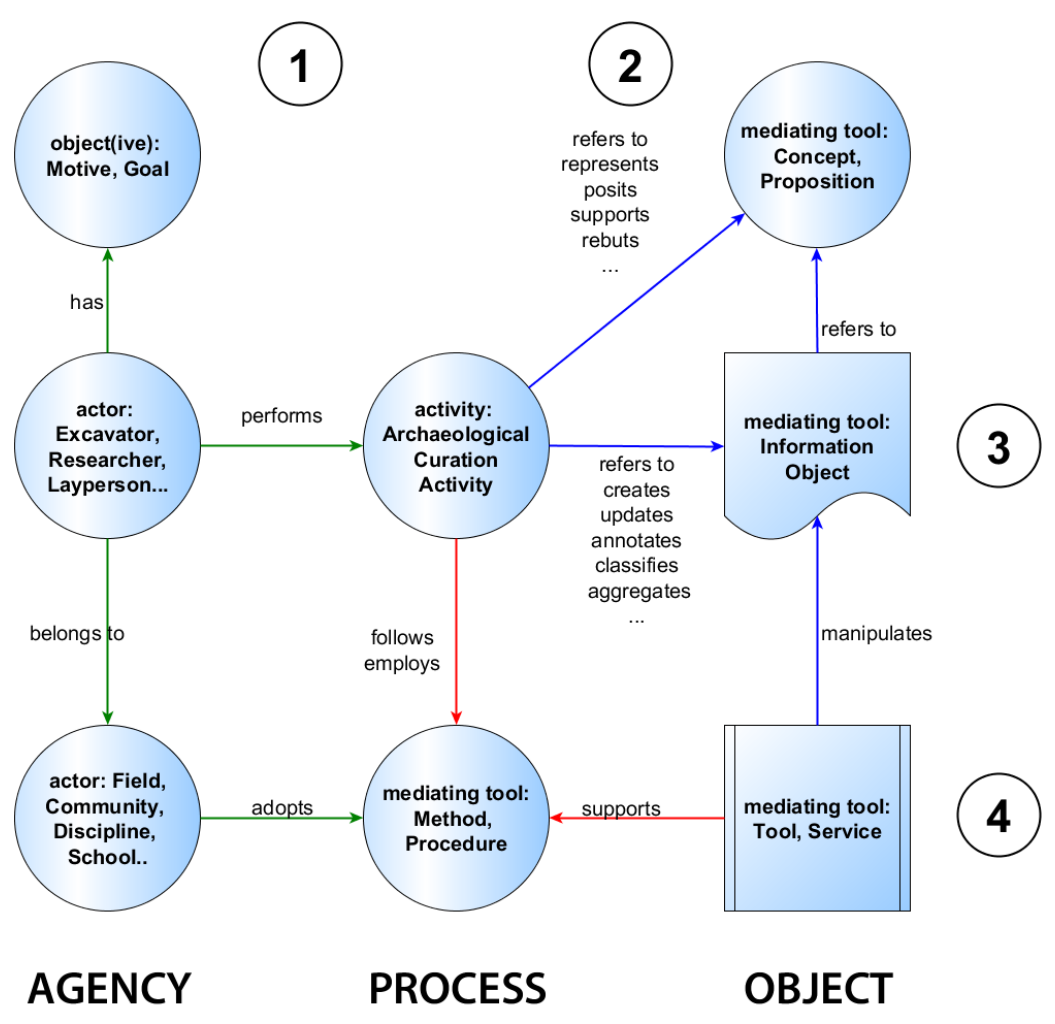
Figure 1 Archaeological curation core activity